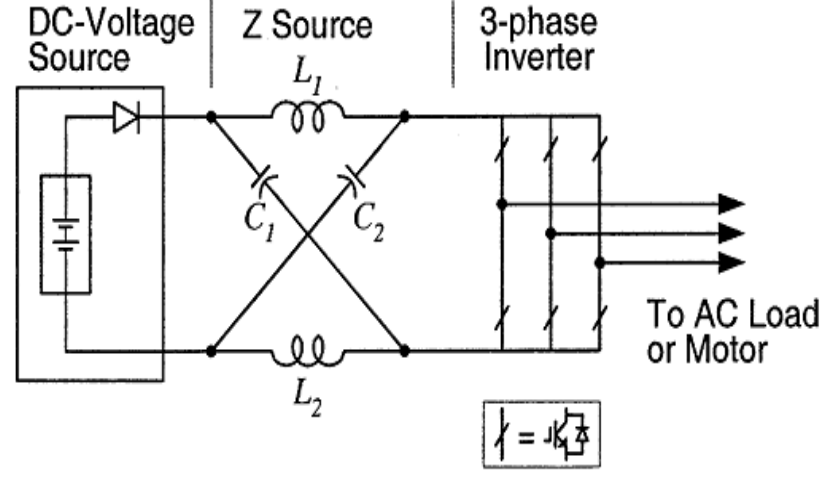
Figure 2. Schematic diagram of a Z-Source VSC.